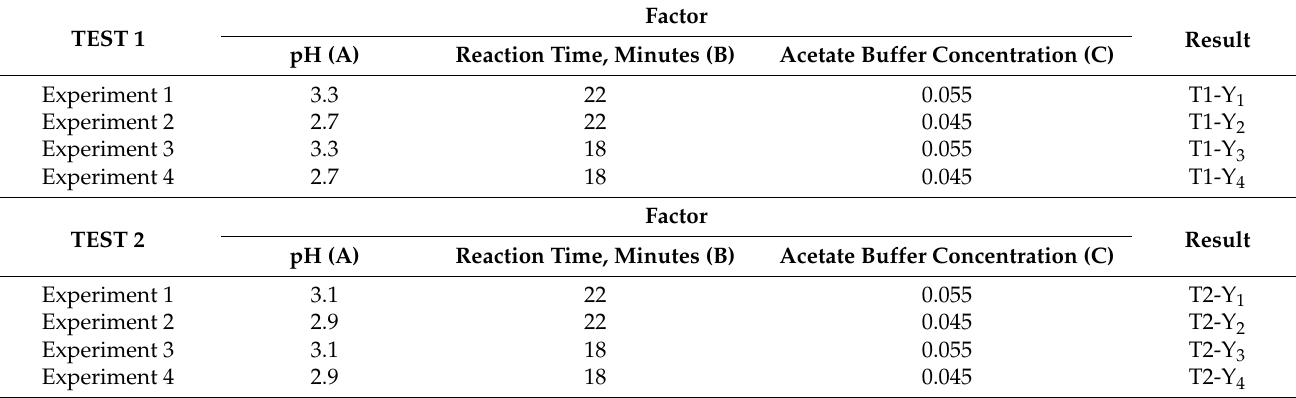
Table 5. The values of the factors for robustness tests.